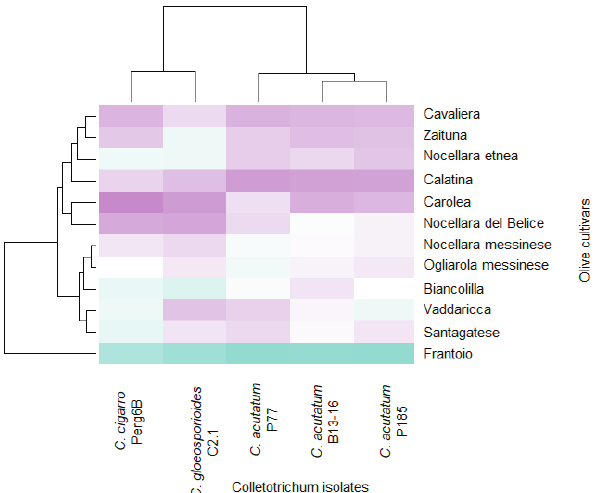
Figure 4. Heatmap and hierarchical clustering of olive fruit suscep- tibility to anthracnose in 11 Sicilian cultivars, using severity of the disease as the dependent variability to indicate similarity between olive cultivars or Colletotrichum strains. The clustering analysis showed three main groups for cultivar susceptibility and two main groups for pathogen strain virulence.